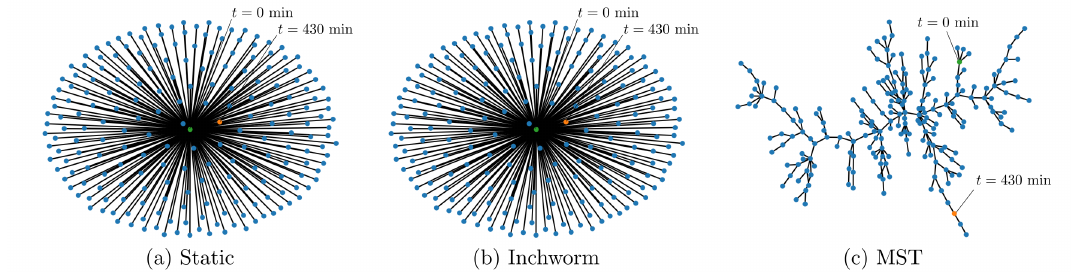
Figure 6. Examples of graphs generated from optical fibers with Type-II FBGs using a static reference ( a ), the inchworm algorithm [31] ( b ), and a maximum spanning tree (MST) algorithm ( c ). The node representing the initial measurement ( t = 0 min) is shown in yellow, and the final measurement ( t = 430 min) is shown in green.